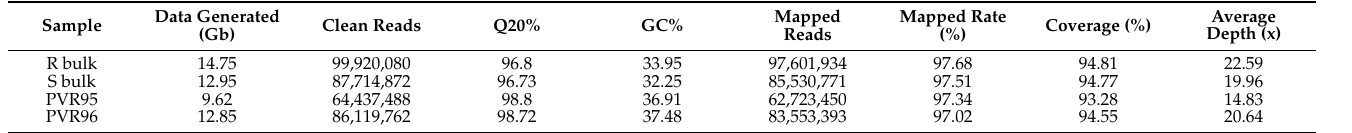
Table 1. Sequencing information of parental lines and bulks for rust